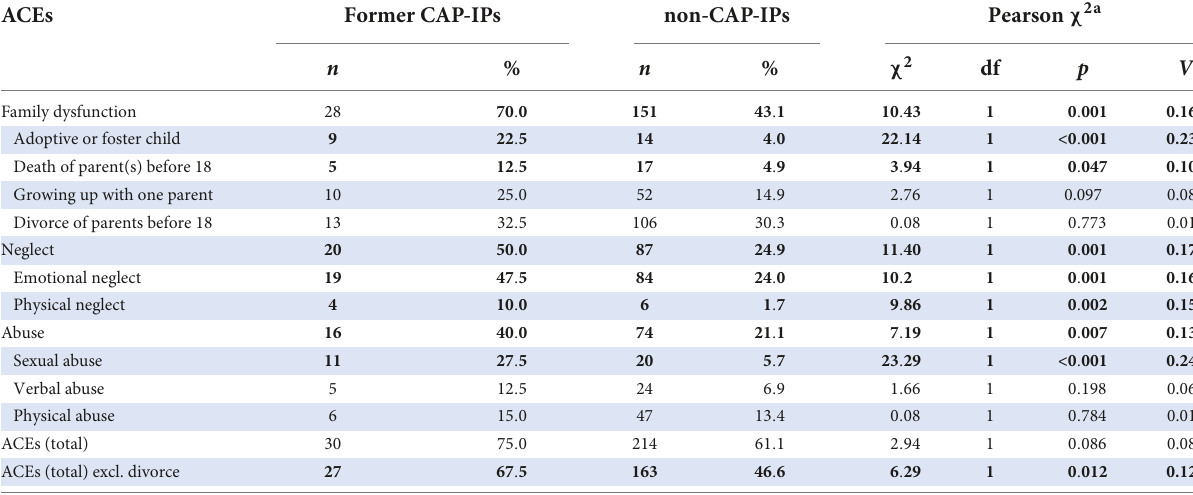
TABLE 2 Comparison of recorded adverse childhood experiences (ACEs; n , %, Pearson χ 2 ) in young adult inpatients with a former child- and adolescent psychiatric inpatient treatment (former CAP-IPs) and those without (non-CAP-IPs).